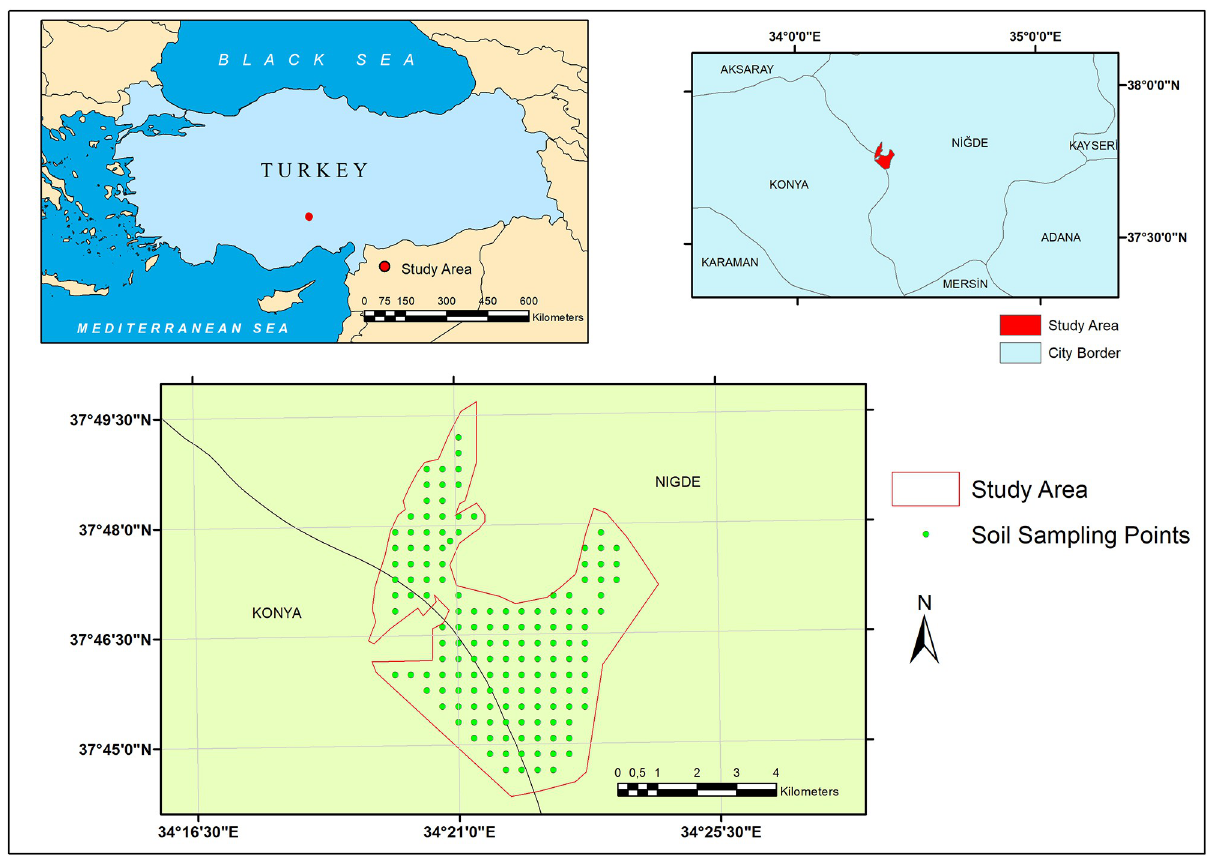
Fig 1. Location of the study area and soil sampling